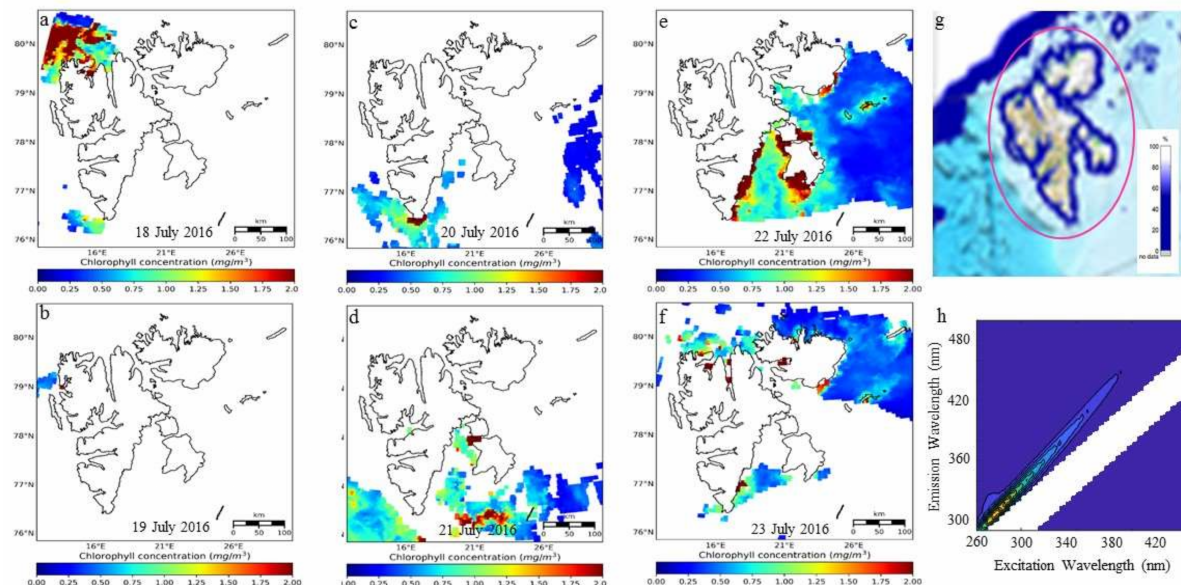
Figure 6. Satellite image (MODIS-Aqua) of chl- a concentration ( a – f ) and sea ice concentration ( g ) from 18–23 July 2016 around Svalbard fjords. A typical elongated EEM shape for pore water at P5 site which often observed in marine ecosystems affected by sea ice algal bloom ( h ). Chl- a data at the fjords cannot be retrieved directly due to cloudiness. The sea ice concentration was obtained from http://www.meereisportal.de (grant: REKLIM-2013-04) (Refer to Spreen et al.